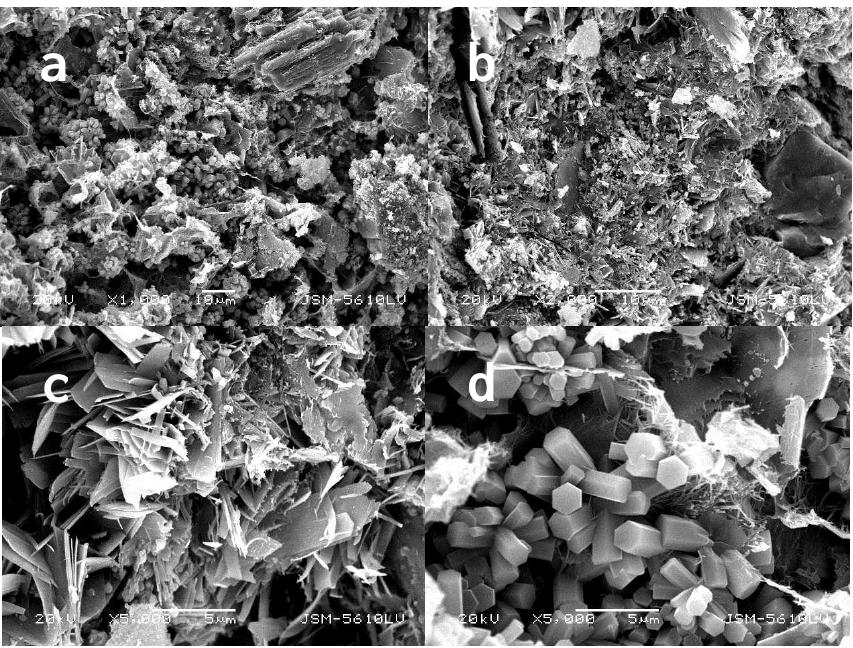
Figure 8. Scanning electron microscope (SEM) morphologies of the autoclaved bricks by calculated aggregate gradation and the optimum autoclave system.